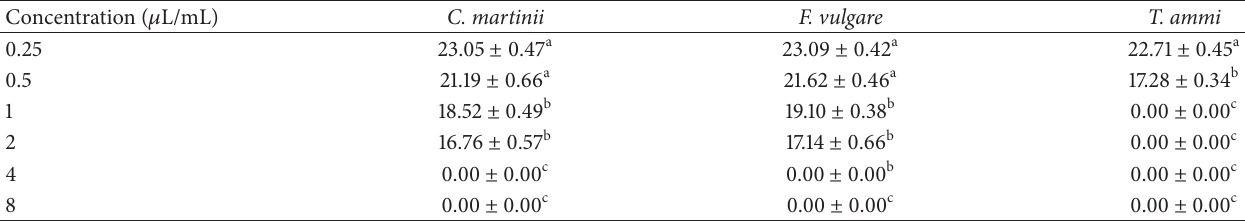
Table 4: Antifungal activity of essential oils against the toxigenic strain of Aspergillus flavus using agar dilution technique. Concentration ( 𝜇 L/mL)